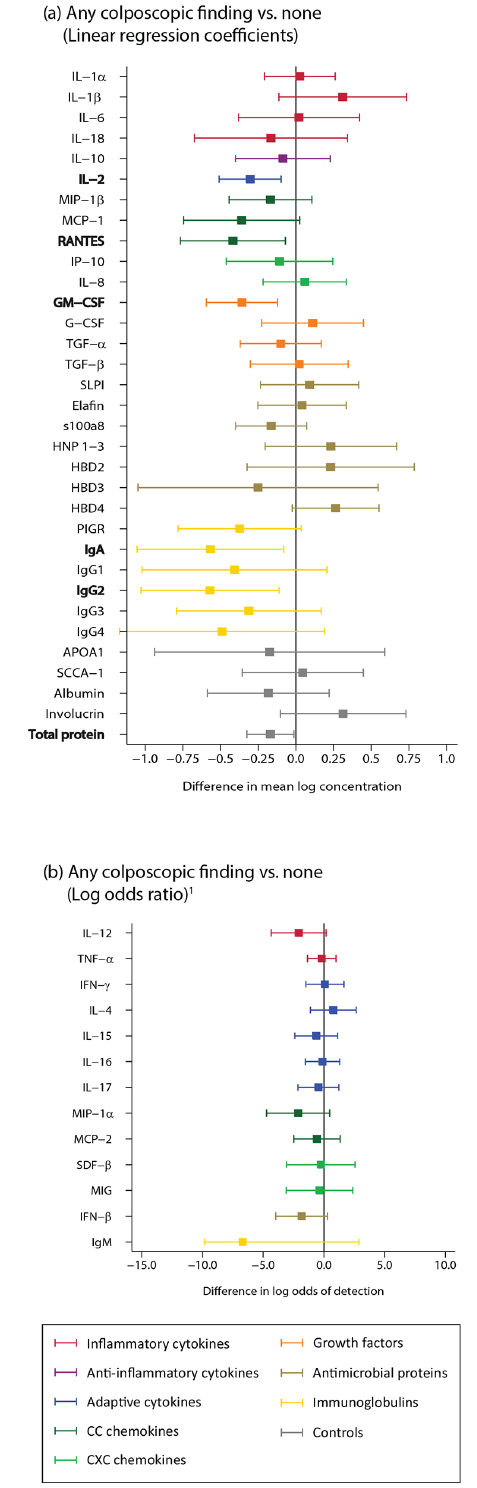
Fig 7. Colposcopy examination (n = 67). Bolded analytes represent associations with a p-value (cid:1) 0.05. A comparison of analyte concentration between samples among women with colposocopic findings and women without colposcopic findings (reference). (A) Analytes with > 85% detection using linear regression; (B) Analytes with < 85% detection using logistic regression. Footnote: 1. The x-axis range is from -15.0 to +10.0 which is wider than for all other